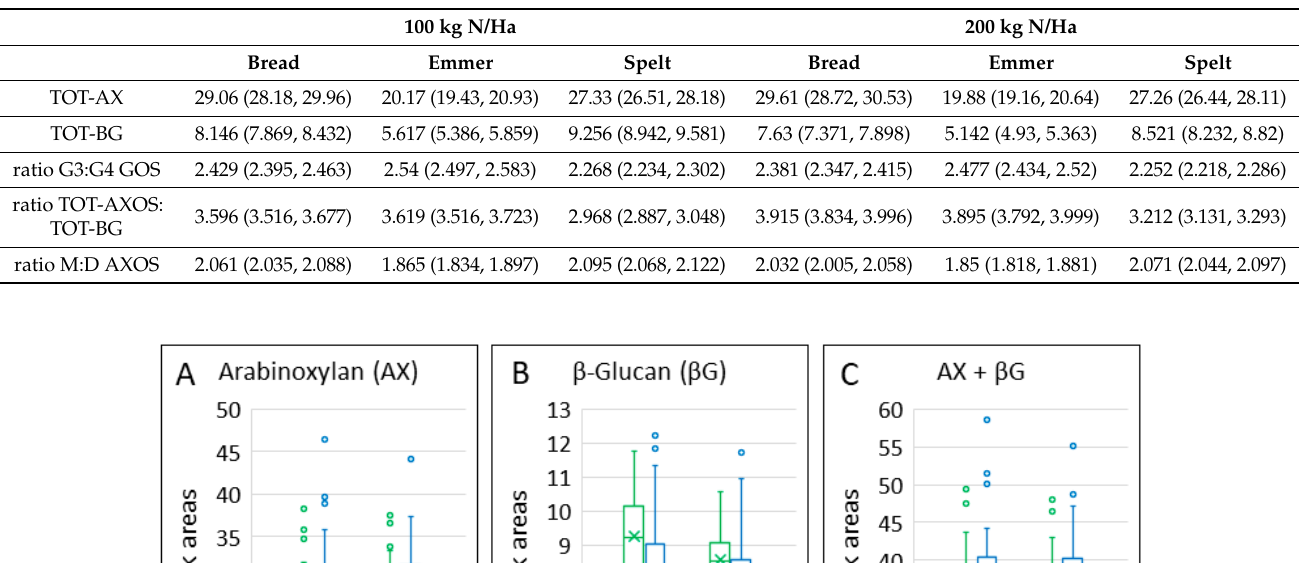
Table 3. Means and 95% confidence intervals (in parentheses) of contents and compositions of